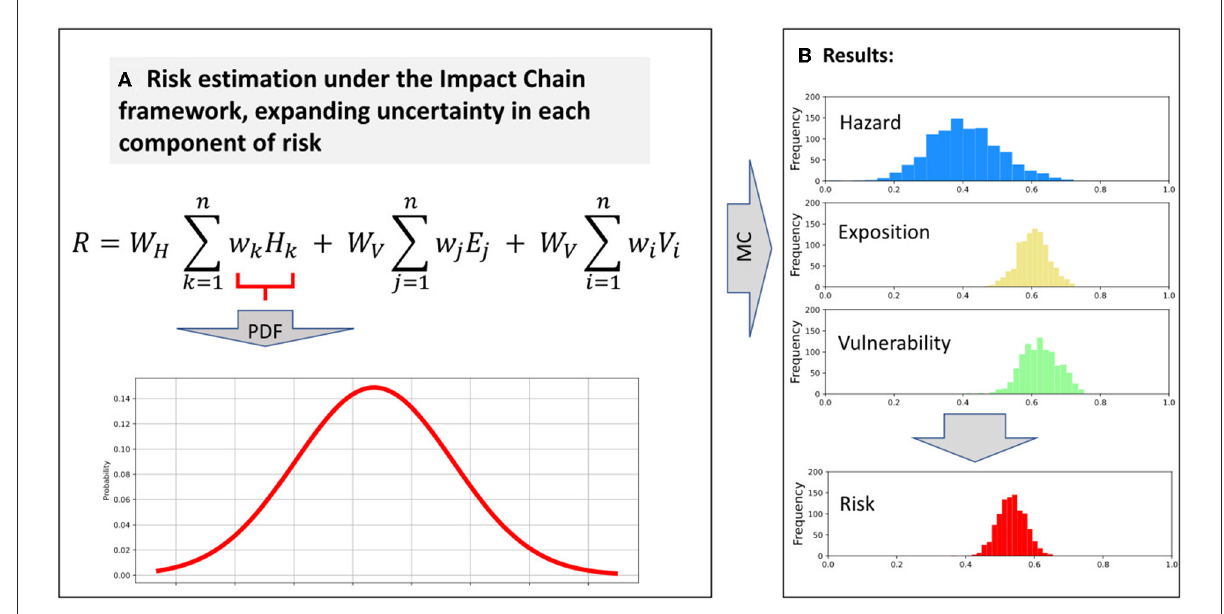
FIGURE1 Sketch of the methodology proposed to accommodate uncertainties in the impact chain framework. (A) Risk estimation under the Impact Chain framework, expanding uncertainty in each component of risk. (B)